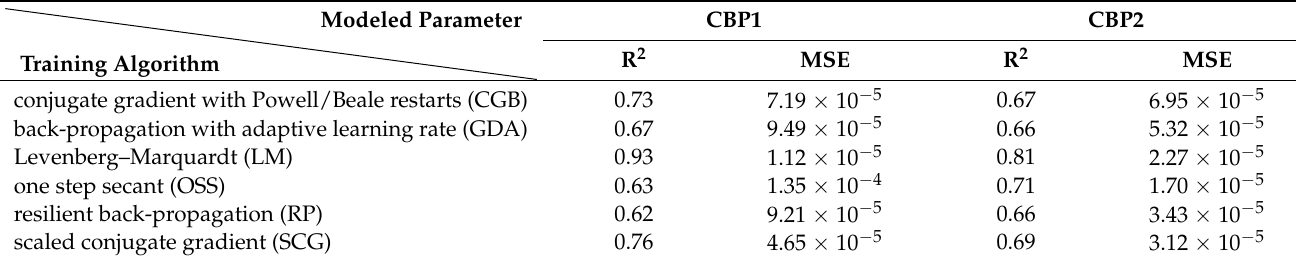
Table 5. Comparison between the performance of various ANN training algorithms for bins 1 and 2.